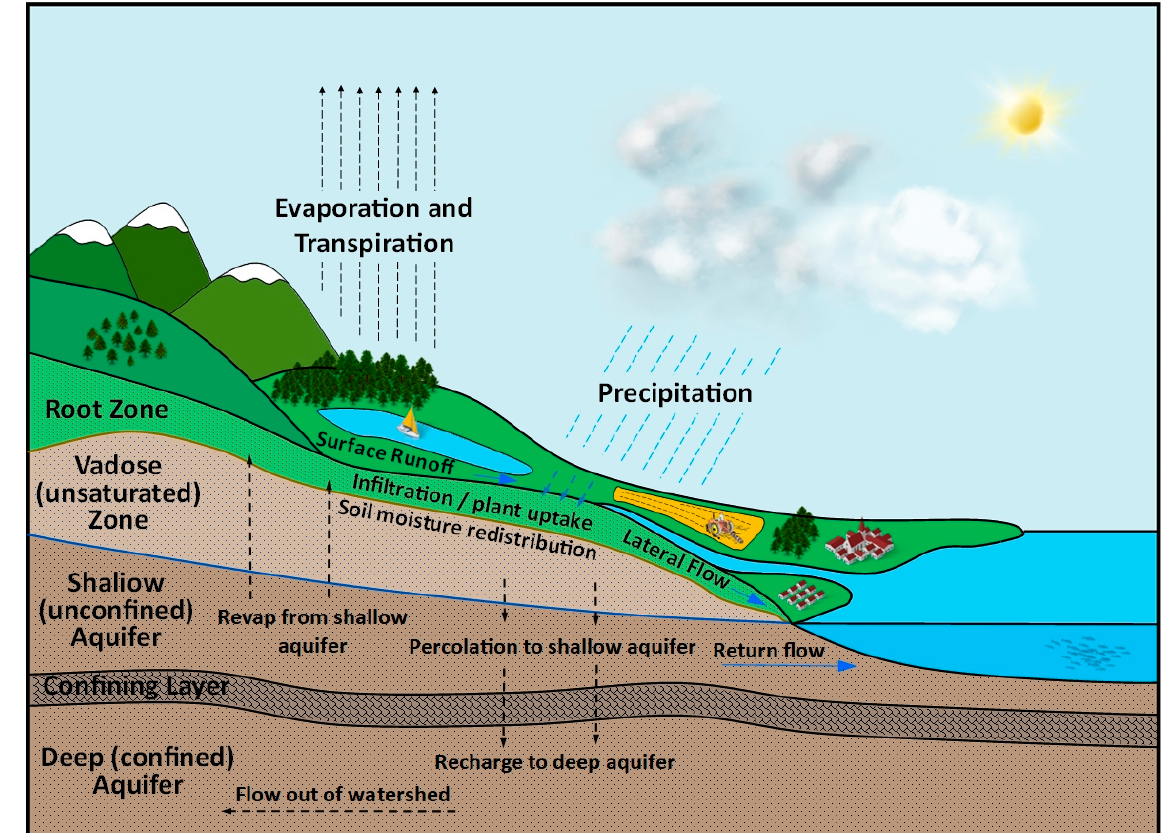
Figure 5. Schematic illustration of the conceptual water balance model in SWAT (own study).